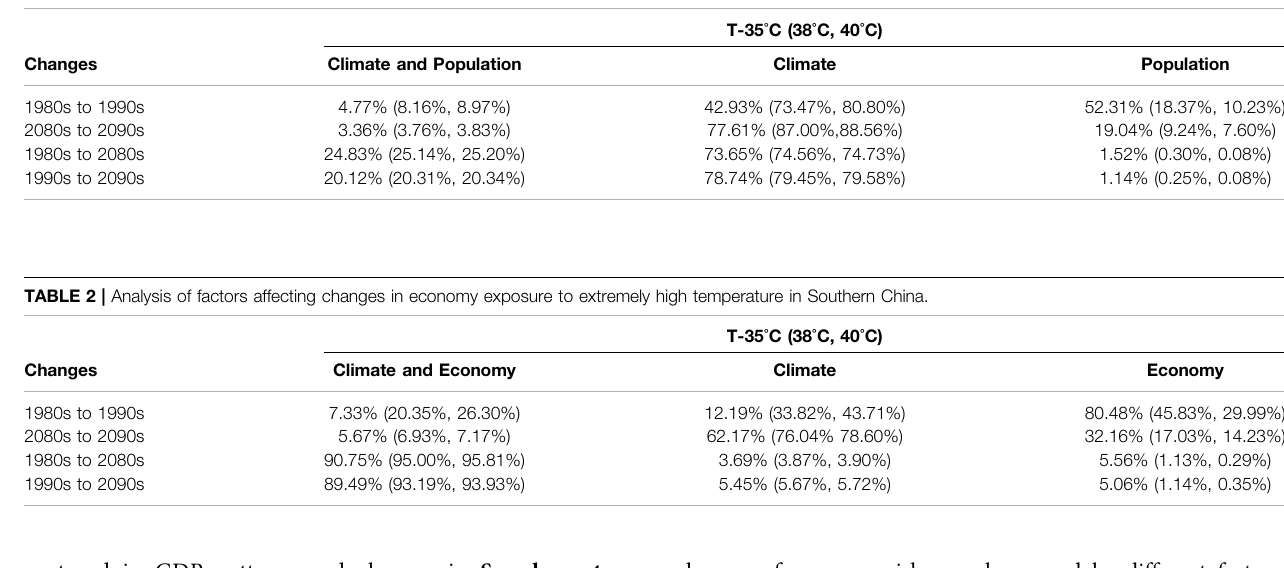
Figure 3 . The Southern China Region has been experiencing